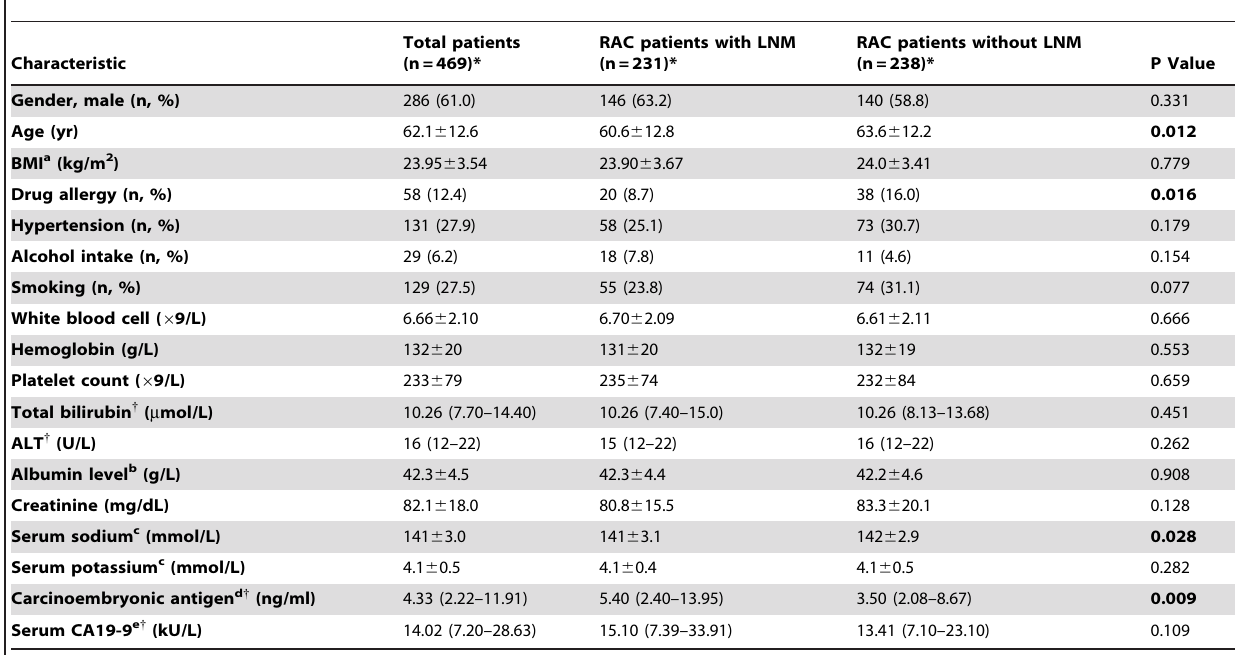
Table 1. Basic characteristics of 469 patients with rectal adenocarcinoma